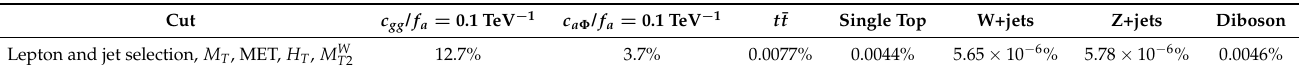
Table 1. Efficiency of cuts for two signal cases with ( c gg / f a = 0.1 TeV − 1 , m a = 1 MeV);